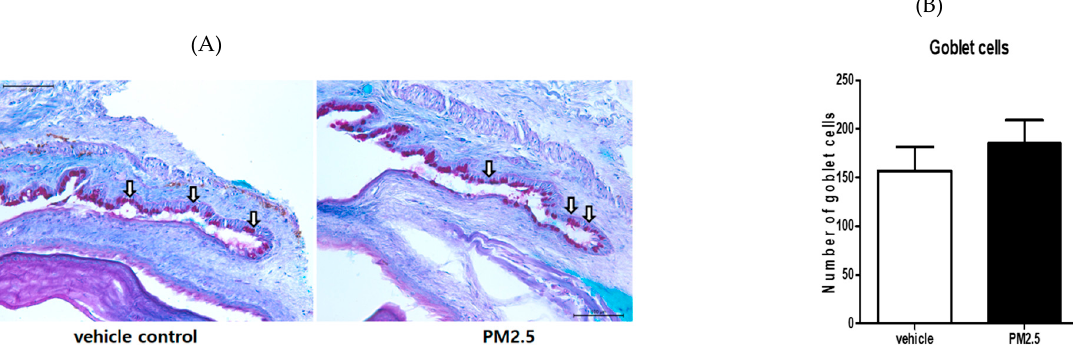
Figure 6. Conjunctival goblet cell density after PM 2.5 exposure. ( A ) Representative photograph of periodic acid Schiff (PAS) staining of the conjunctiva at Day 14. (B) The goblet cell counts (white arrow) in the conjunctiva were not different between PM 2.5 and vehicle control mice. The data are presented as the mean ± SEM. Each experiment consisted of four eyes per group. The scale bar indicates 100 μ m.